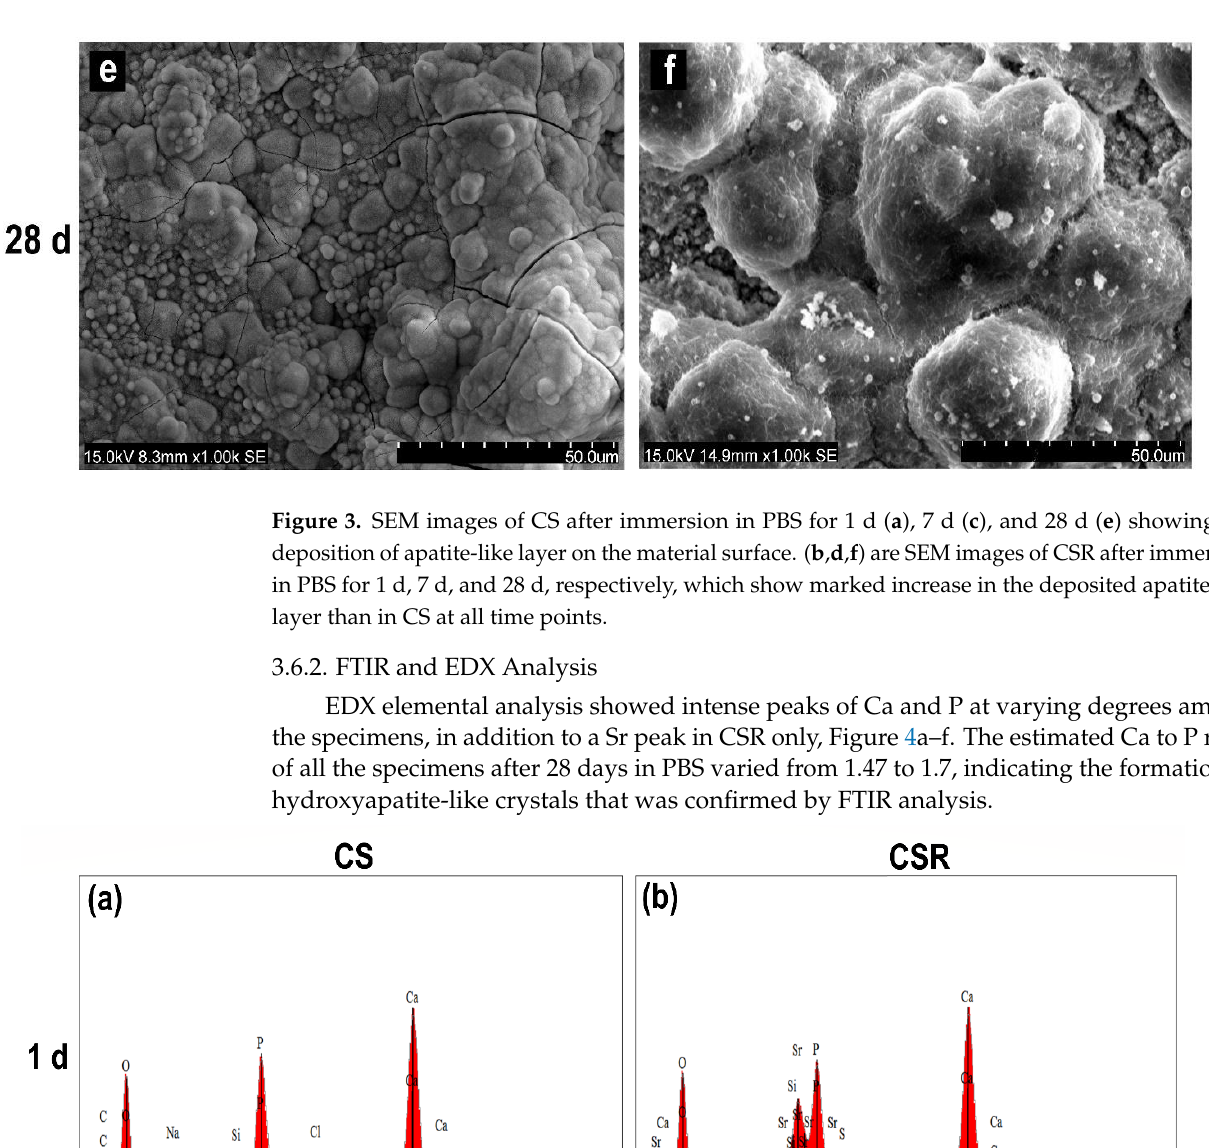
Figure 4. EDX spectra of Ca and P in CS after immersion in PBS for 1 d ( a ), 7 d ( c ), and 28 d ( e ) demonstrate gradual increase in P peak, indicating the formation of apatite-like crystals. Figure 4 ( b , d , f ) show EDX spectra of Ca and P in CSR which also demonstrated gradual increase in P peak as an indicator for apatite crystals deposition. Sr peak was detected in CSR only.